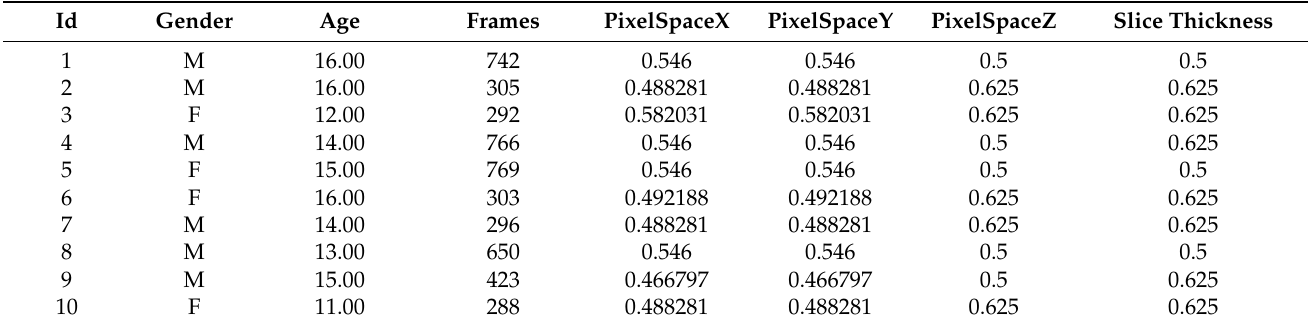
Table 3. Skull CT